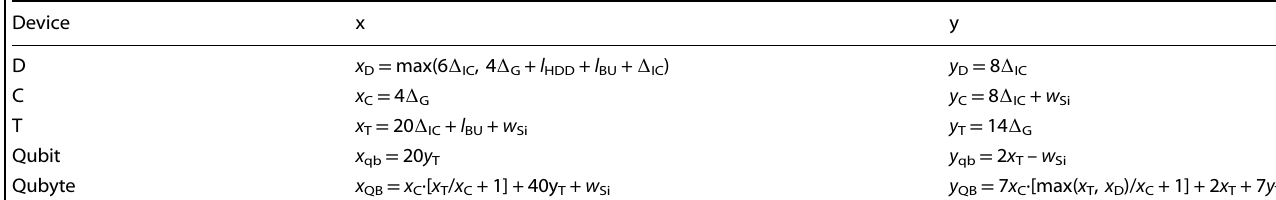
Table 1. Physical size of the three building blocks for QIP, of a logical qubit and of a qubyte as a function of the main critical sizes independent of the technological node